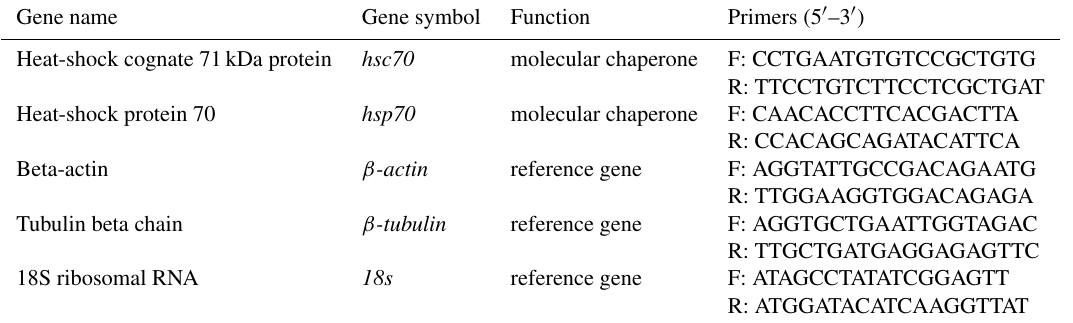
Table A1. Functions and primers of selected genes of the Cellana limpet.